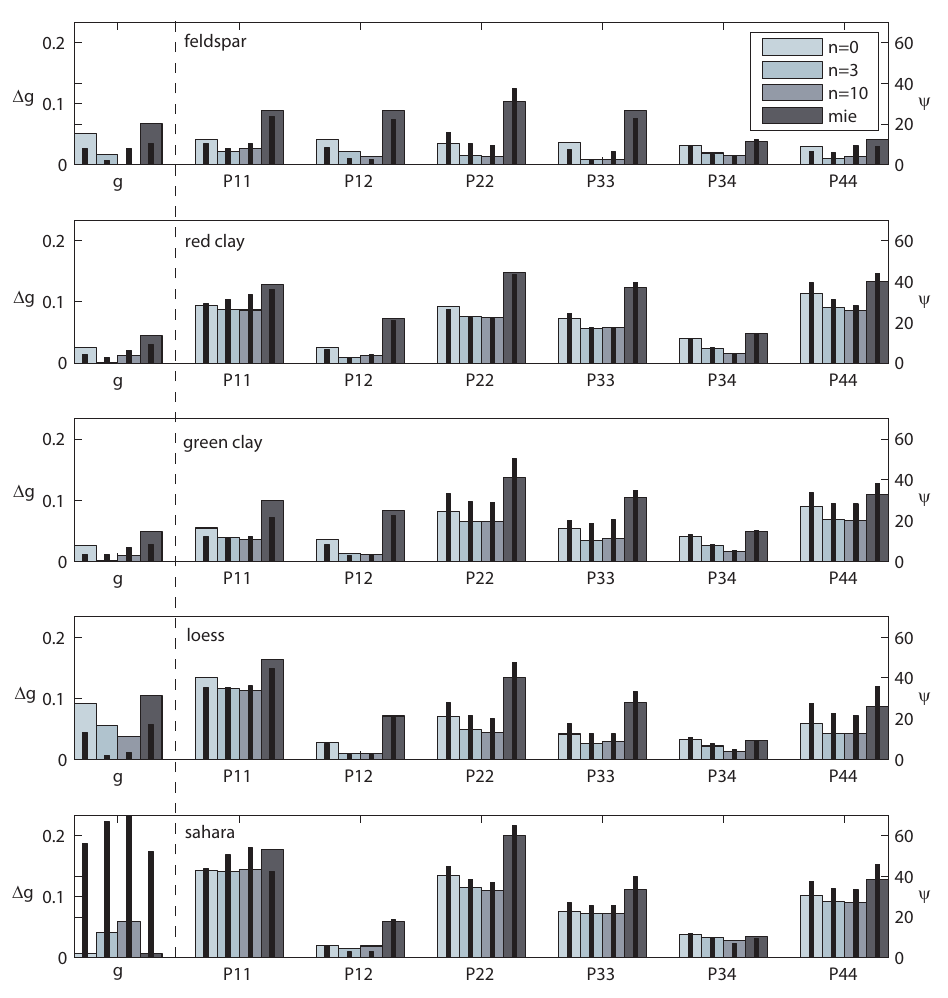
Fig. 6. ψ values, Eq. (10), for model scattering-matrix elements and asymmetry parameter error compared to the measurements. Wider bars correspond to the wavelength of 632 . 8nm, whilst the thinner bars represent 441 . 6nm. Each row corresponds to one sample from the smallest (feldspar) to the largest effective radii (Sahara). On each row there are seven bar groups. The left-most group and the left y-axis shows the asymmetry parameter error, whilst the other groups and the right y-axis are for different scattering-matrix element ψ values. In each group three different representations of the ξ n distribution, Eq. (6), namely n = 0, 3 and 10, are shown. The darkest rightmost bar represents the ψ value obtained when using Mie